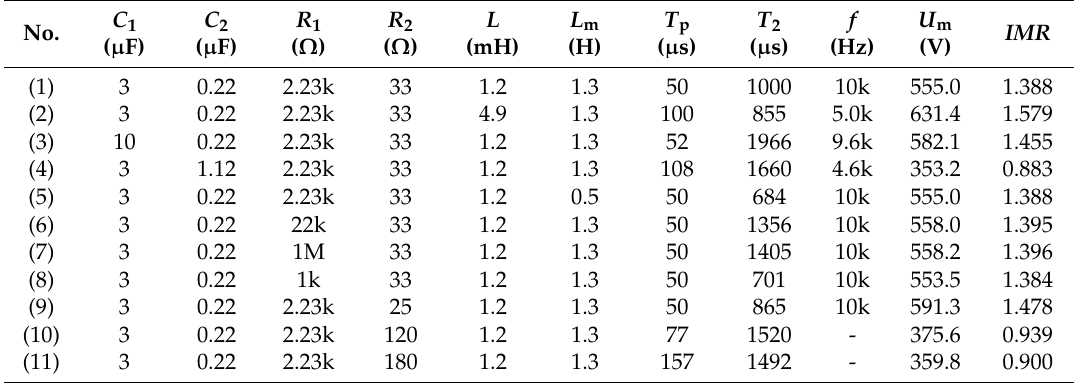
Table 2. Waveform parameters of OSI voltage and their corresponding circuit parameters.